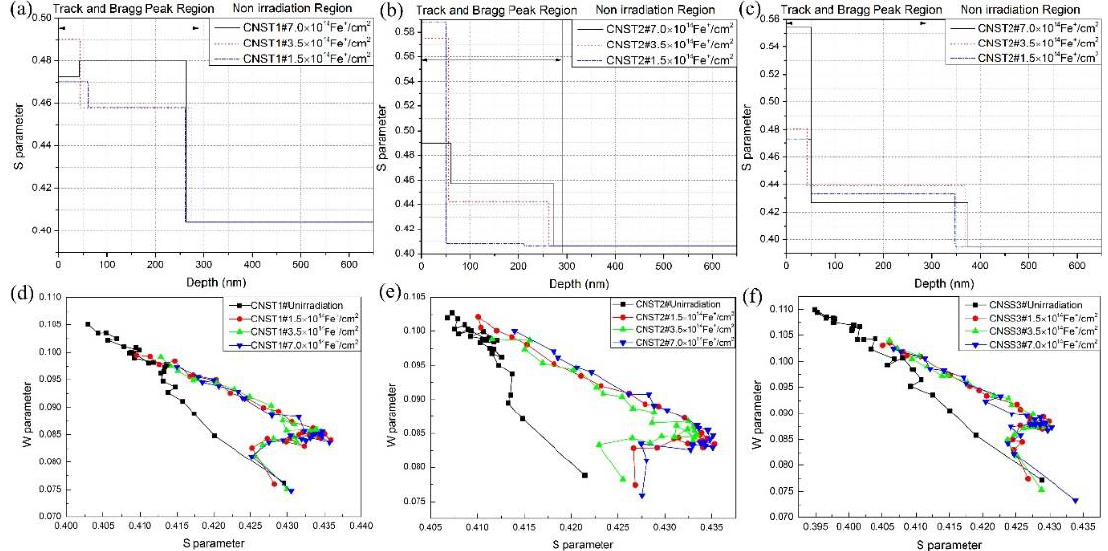
Figure 6. The S parameter obtained from VEPFIT vs. the positron mean implantation depth and the relationship between S-W parameter, ( a , d ) CNST1 steel; ( b , e ) CNST2 steel; ( c , f ) CNSS3 steel.